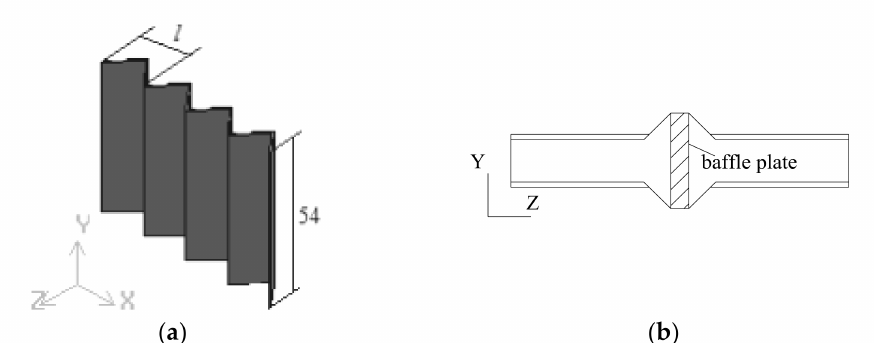
Figure 2. Cross section view of the shell side of the SS-RCD tube bundle heat exchanger. ( a ) Schematic diagram of heat exchanger. ( b ) Cross section of A-A.